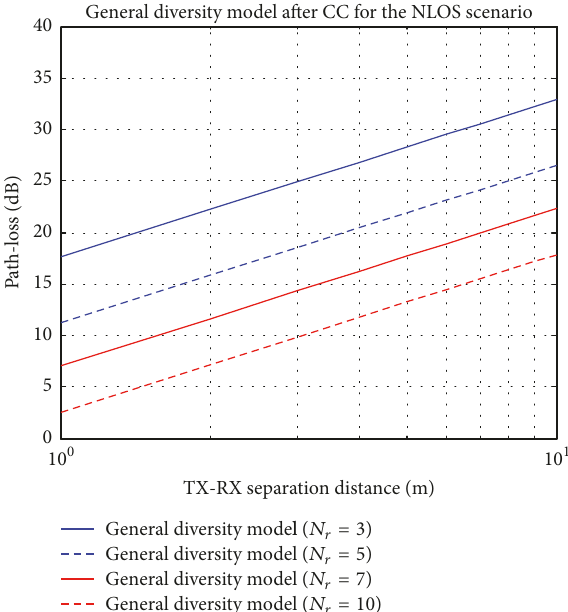
Figure 19: Path-loss for the proposed floating intercept-based diversity model given by (6) for the NCC scheme when considering NLOS scenario, with 𝛼 SISO = 31.36 , 𝛽 SISO = 1.53 , and 𝐵 = 0.192 . Solving for 𝐴 we get the final formula as